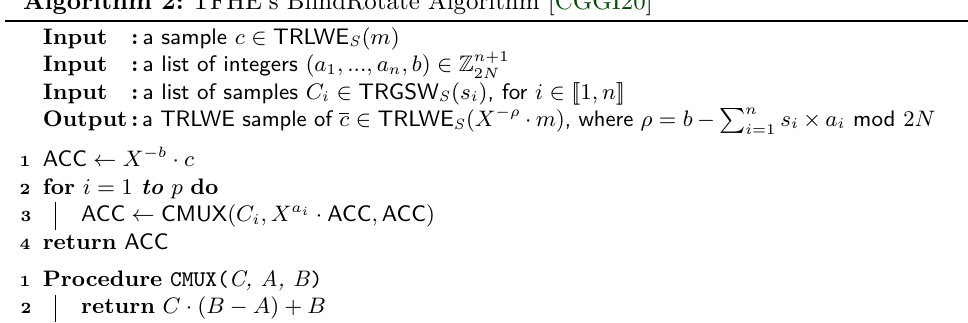
Algorithm 2: TFHE’s BlindRotate Algorithm [CGGI20]